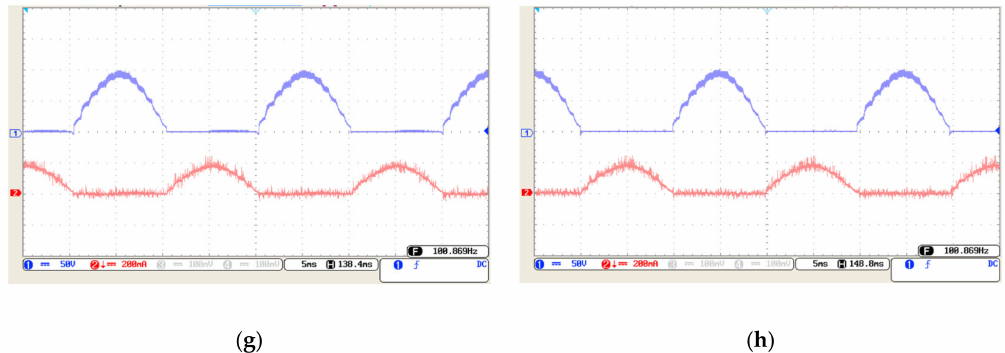
Figure 10. Experimental test waveform of output voltages and currents for the proposed multilevel inverter: ( a ) the voltage and current of S1; ( b ) the voltage and current of S2; ( c ) the voltage and current of D1; ( d ) the voltage and current of D0; ( e ) the voltage and current of S3; ( f ) the voltage and current of S4; ( g ) the voltage and current of S5; ( h ) the voltage and current of S6.